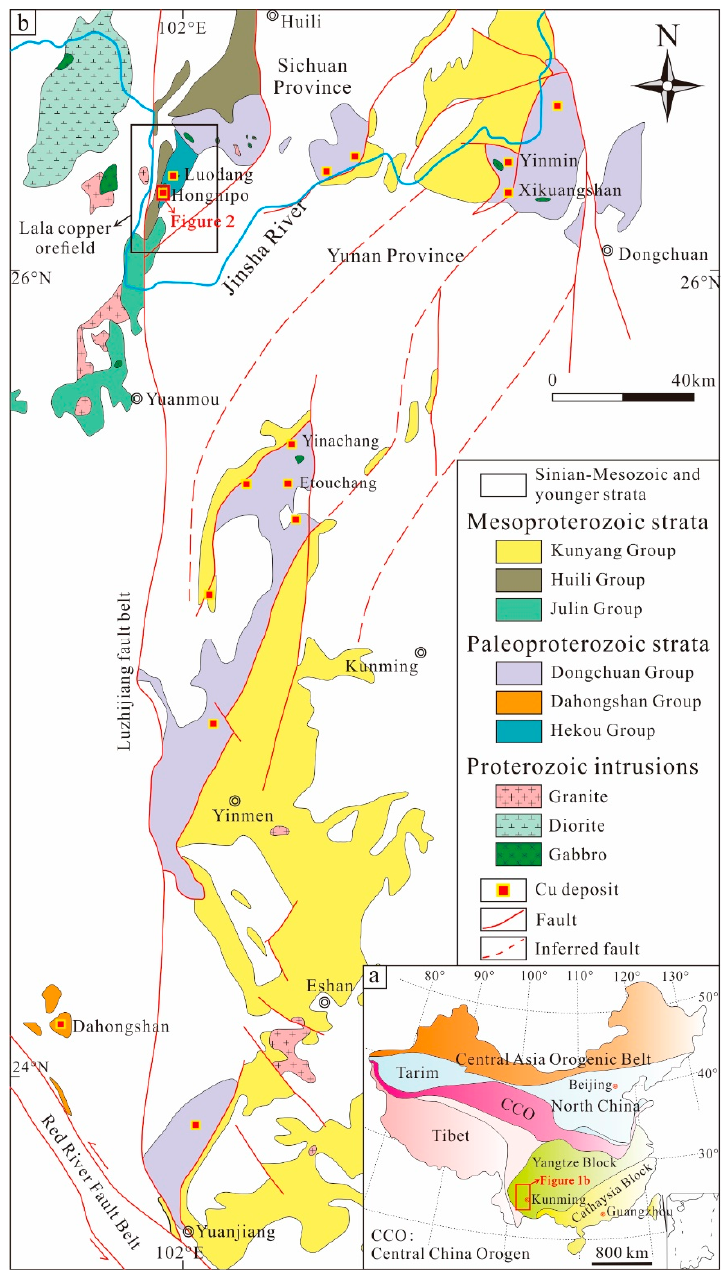
Figure 1. ( a ) Simplified geotectonic map showing the study area in the Yangtze Block (modified after [70]); ( b ) Regional geologic map showing Precambrian strata, intrusions and major Fe-Cu and Cu deposits in the Kangdian copper belt (modified after [16,59]).